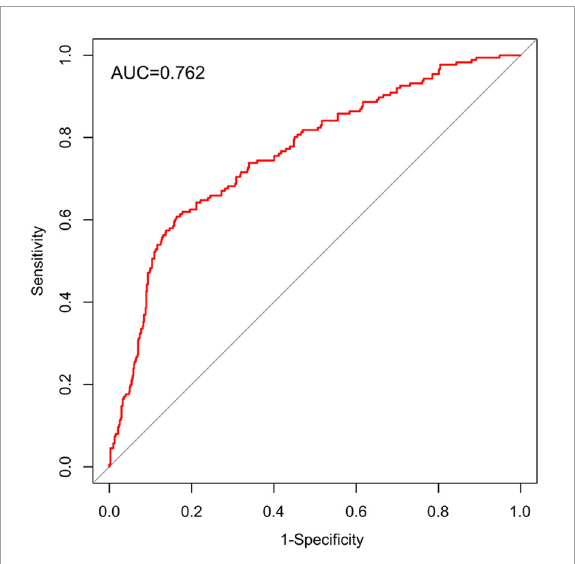
FIGURE3 Area under the curve (AUC) of the ROC curve in the training set.